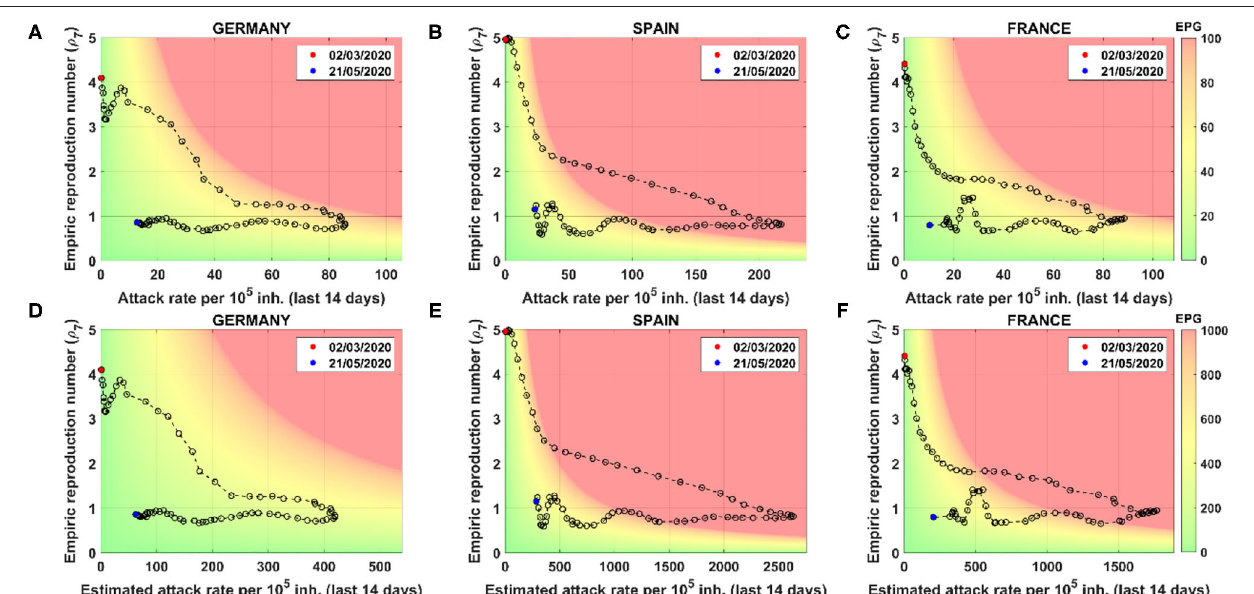
FIGURE 4 | Risk diagrams for different countries using reported and estimated cases. Each point represents a different day. Starting and final days are marked by date. Color code depends on Effective Potential Growth (EPG). Two color codes are used: one for reported (top right bar) and another for estimated (bottom bar). Using reported cases: (A) Germany, (B) Spain, and (C) France risk diagrams. Using estimated cases: (D) Germany, (E) Spain, and (F) France risk diagrams. Note that x-scales are different, but plots can be compared through the color